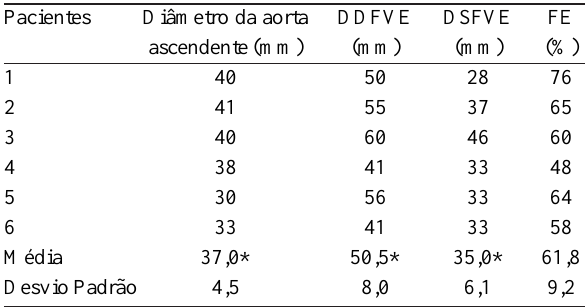
Tabela 4. Ecocardiograma pós-operatório.